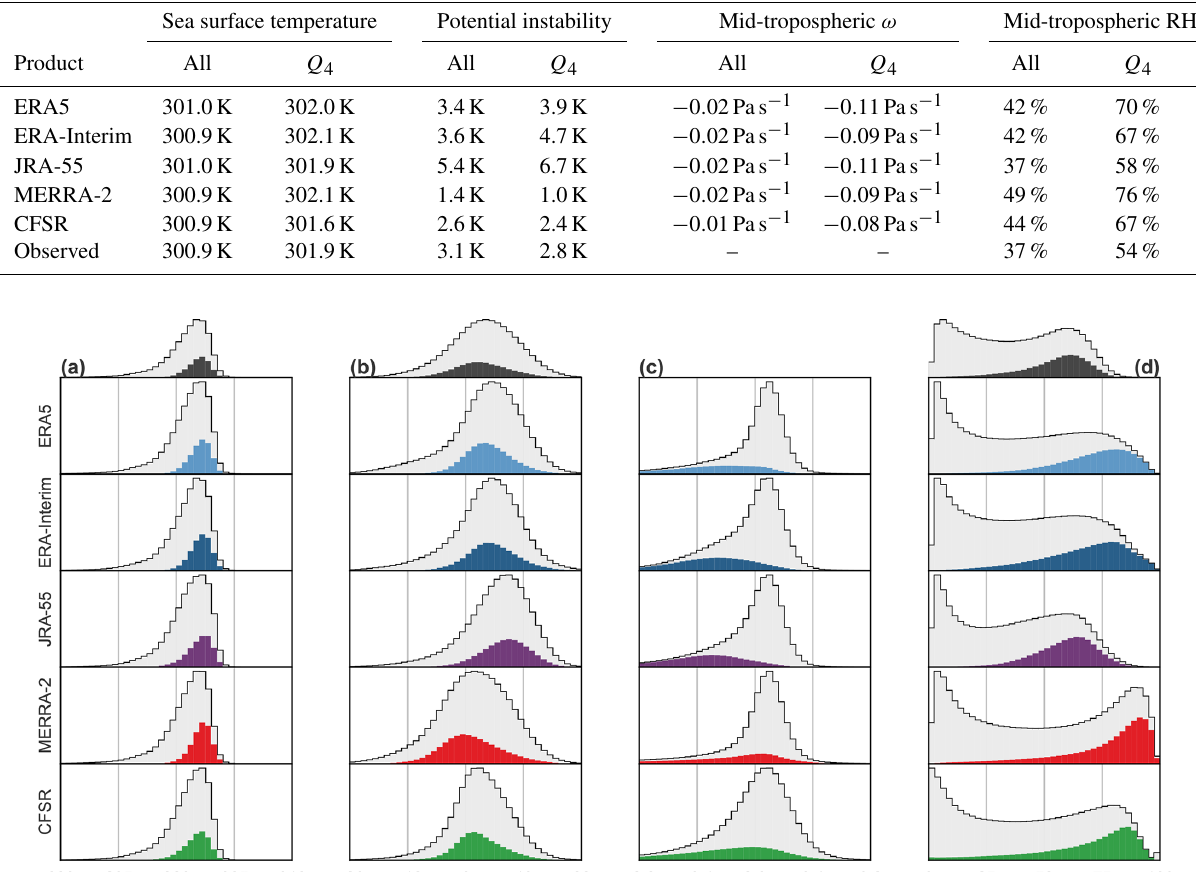
Table 3. Mean values of the distributions shown in Fig. 10 for all data points in the inner tropics (All; 10 ◦ S–10 ◦ N) and for the top quartile of LWCRE in the same region ( Q 4 ). The row labelled “Observed” summarizes the results when LWCRE is taken from CERES SYN1Deg, SST from OISST v2, and potential instability and mid-tropospheric RH from AIRS.